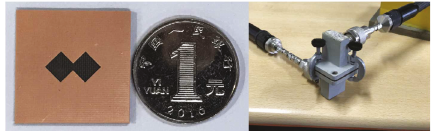
Figure 8: Photograph of the experimental waveguide twist and the proposed waveguide twist assigned between two mutually orthogonal waveguides.